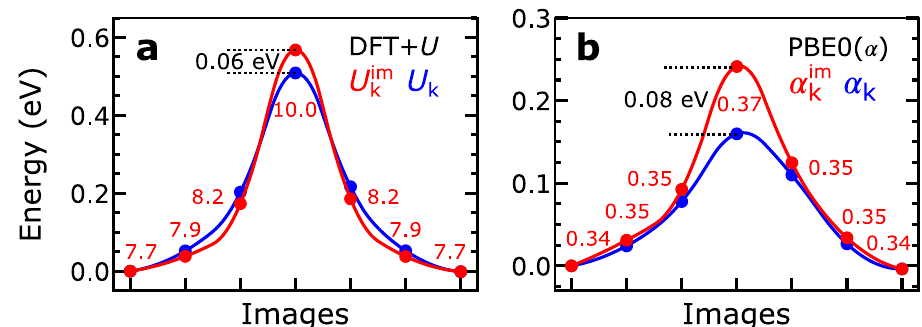
Fig. 5 Polaron hopping barriers obtained with various functionals. Energy along a polaron pathway connecting two neighboring O atoms in MgO, as calculated ( a ) with fi xed U k and image-dependent U im PBE0( α ) calculations. The values of U im